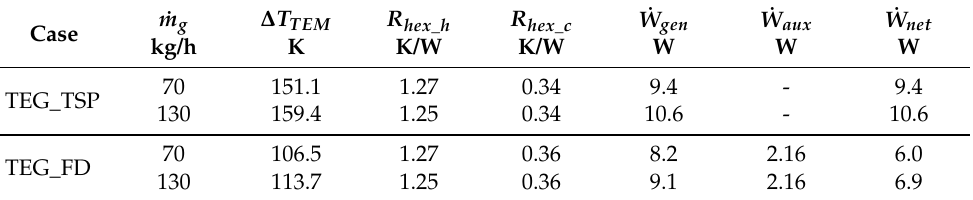
Figure 14. Influence of the auxiliary consumption on the net power output of the thermoelec- tric generators. Table 4. Experimental results of the thermoelectric generators for an inlet temperature of t in g = 405°C, different mass flow rates, and a voltage applied to the fan of the TEG_FD of